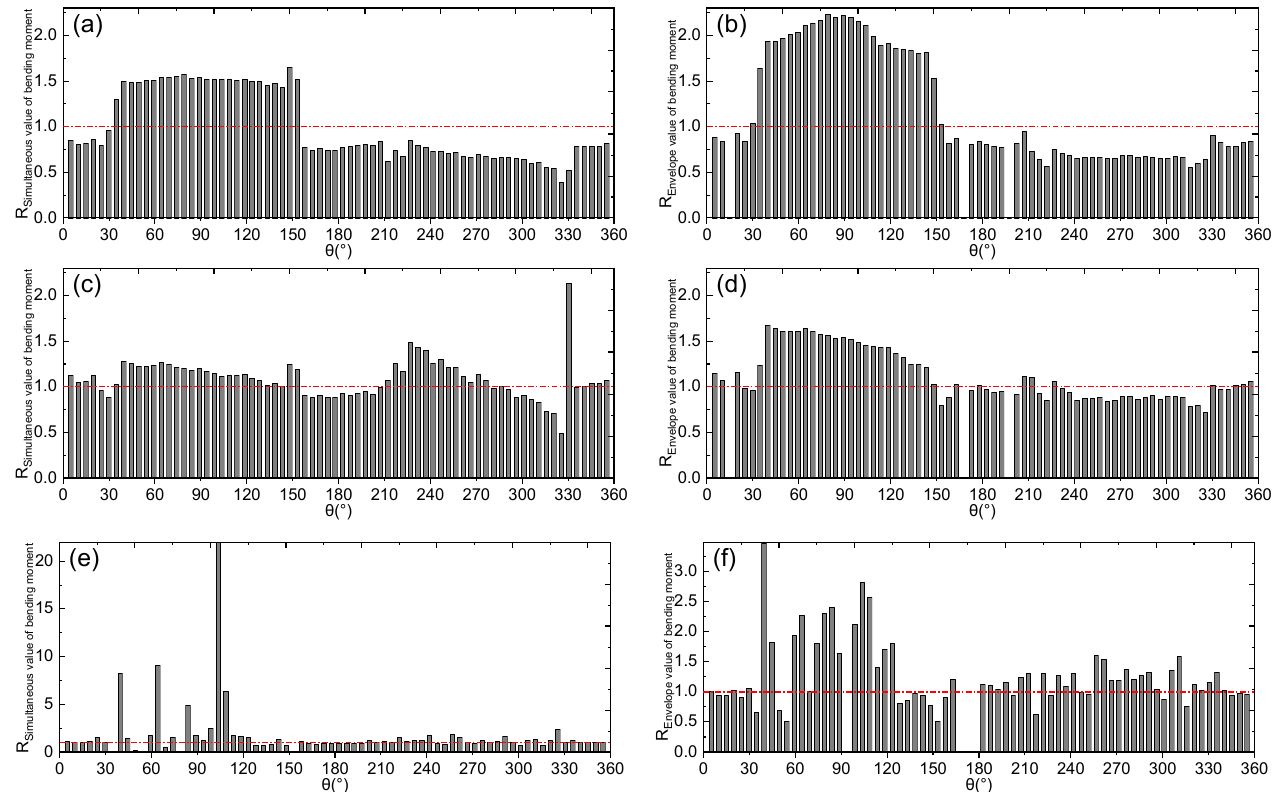
Figure 18. Dynamic response ratio of the bending moment. First row ( a , b ): elastic analysis result. Second row ( c , d ): elasto-plastic analysis result. Third row ( e , f ): damage plastic analysis result.